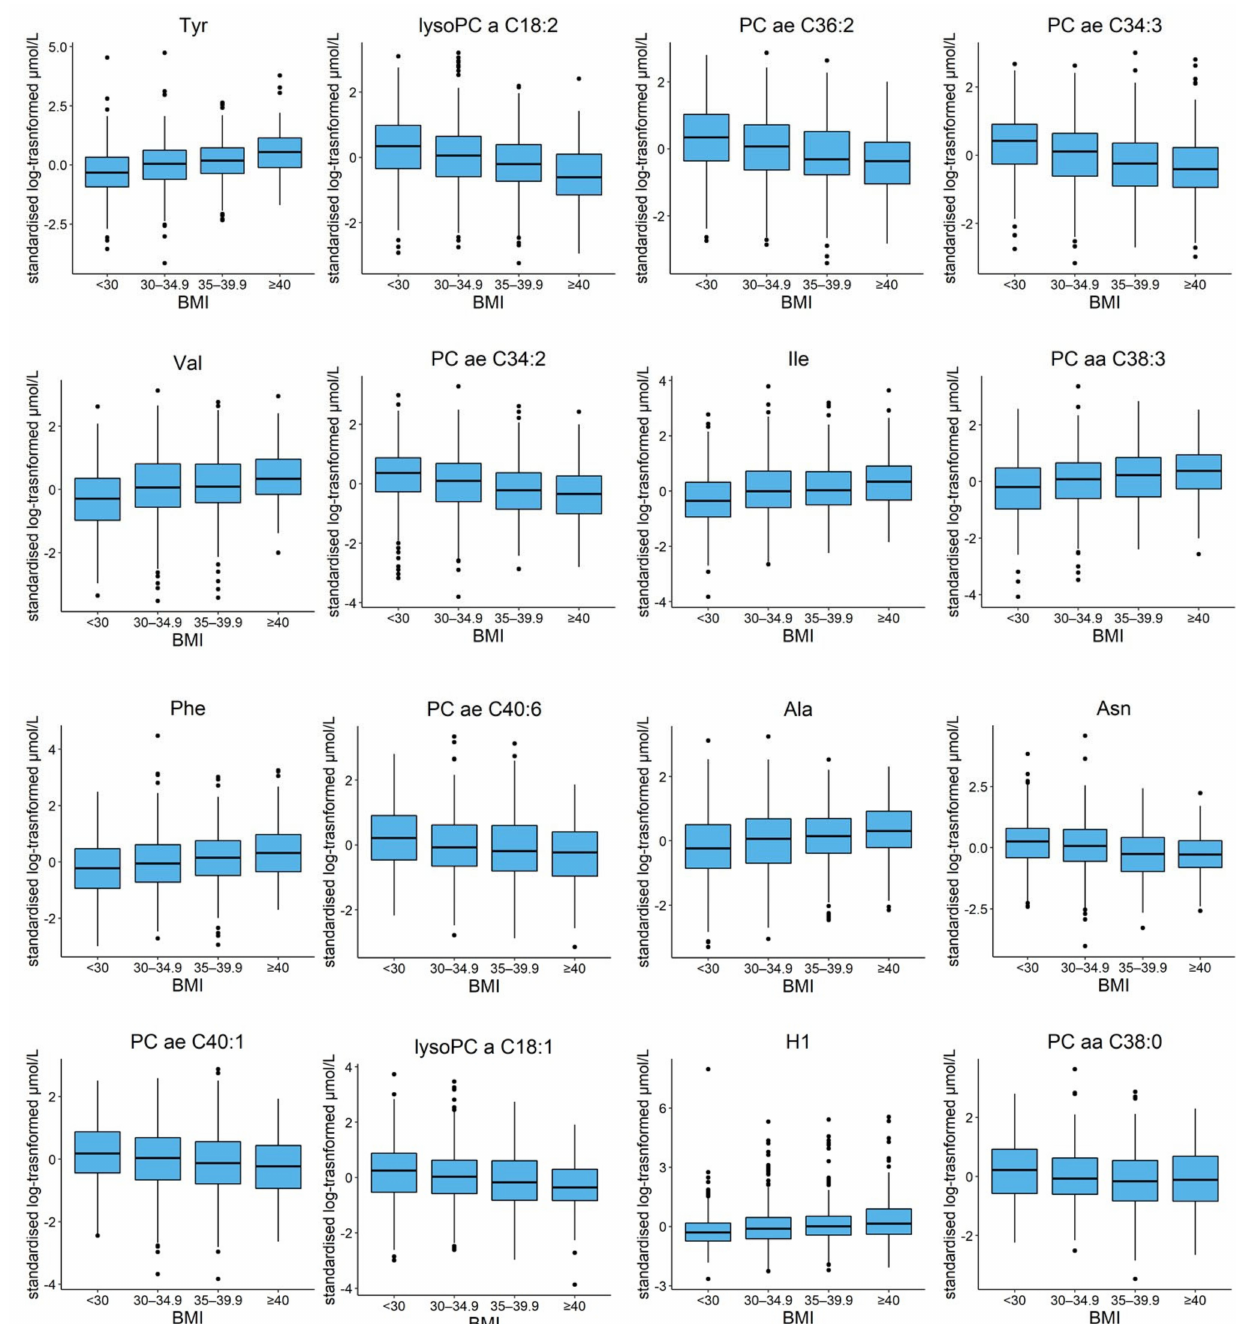
Figure 2. Boxplots summarizing the distribution, for study subjects divided in four different classes of BMI, of the 16 metabolites with the lowest FDR p -value in the Tobit regression models. The box contains 50% of the observations, with the median dividing the box in two areas and the upper and lower hinge representing the 25th and 75th percentile of the distribution. Outside the box, the upper whisker extends from the hinge to the highest value no further than 1.5 times the interquartile range (IQR) from the hinge. The lower whisker extends from the hinge to the smallest value at most 1.5 times the IQR of the hinge. Data beyond the whiskers are plotted individually and represented as